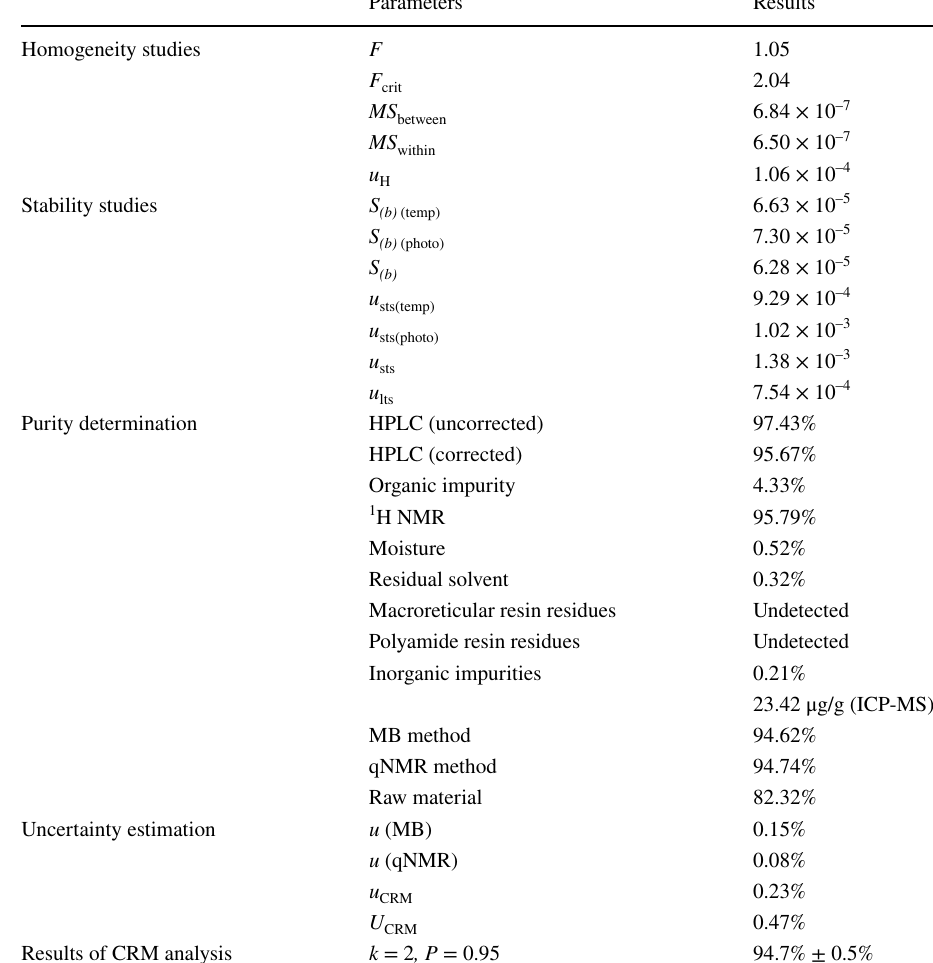
Table 3 Certification results of Sal A candidate